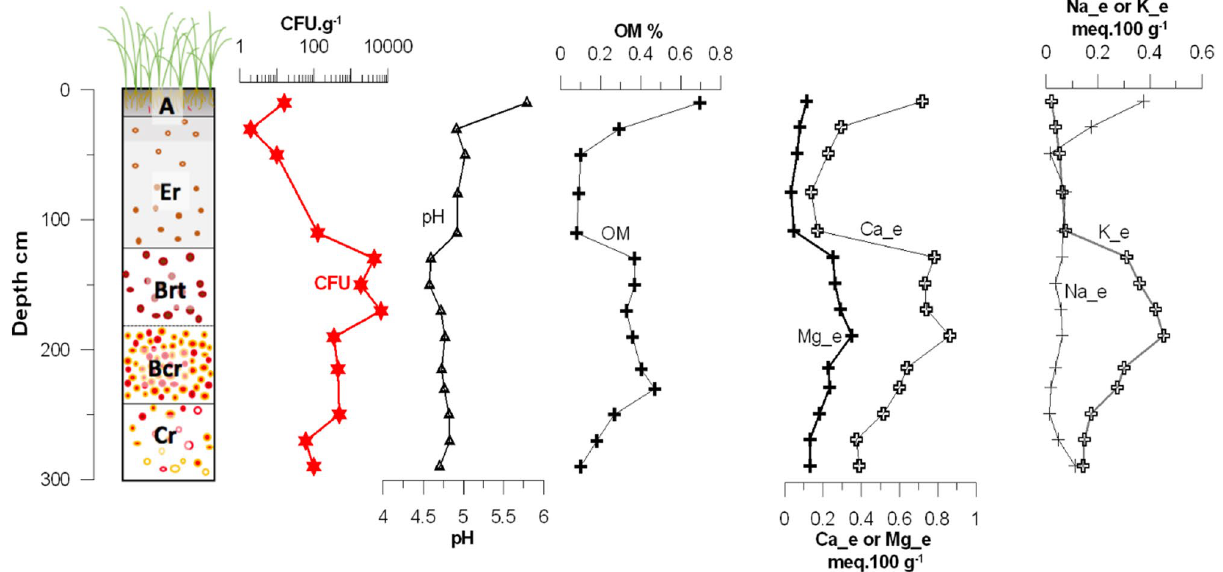
Figure 5. Soil log showing the main pedological horizons (i.e. A, Er, Brt, Bcr and Cr—see caption of Fig. 4 for meaning of abbreviations), semi-quantitative colony forming unit (CFU) counts of B. pseudomallei (CFU g −1 ), and soil physico-chemical parameters along the 300-cm deep profile: pH, organic matter content (OM), exchangeable magnesium (Mg_e), exchangeable calcium (Ca_e), exchangeable sodium (Na_e) and exchangeable potassium (K_e).